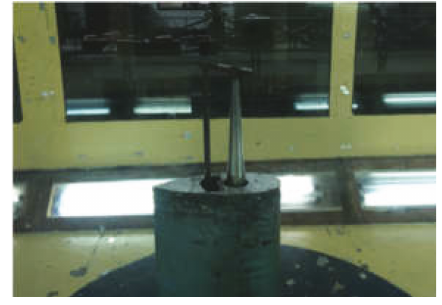
Figure 10: Blow air test of the bracket. Table 5: The comparison of the correlation coe ffi